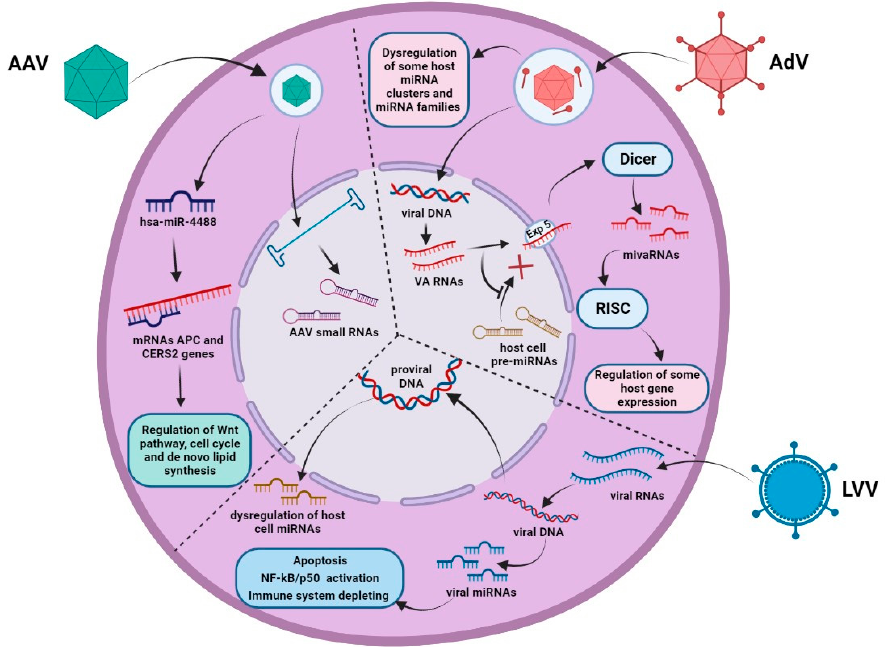
Figure 2. Scheme of miRNA pathway dysregulation by AdV, AAV, and LV infections. Description is within the text. (Created in BioRender.com).